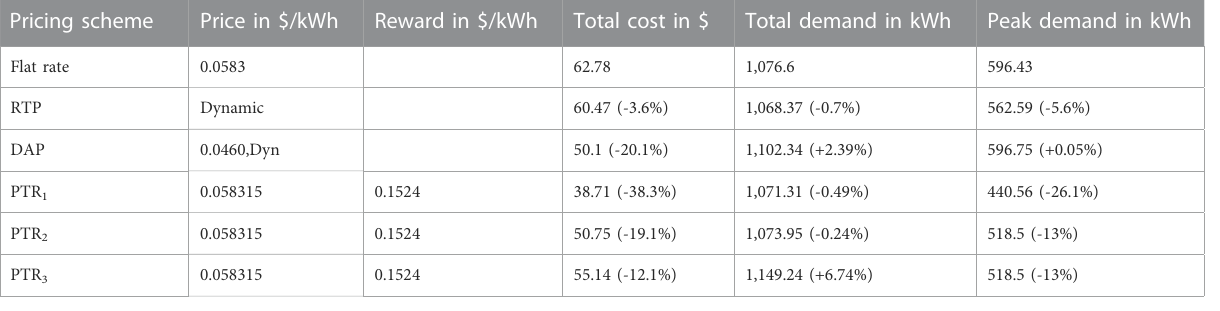
TABLE 5 Results of August 05.